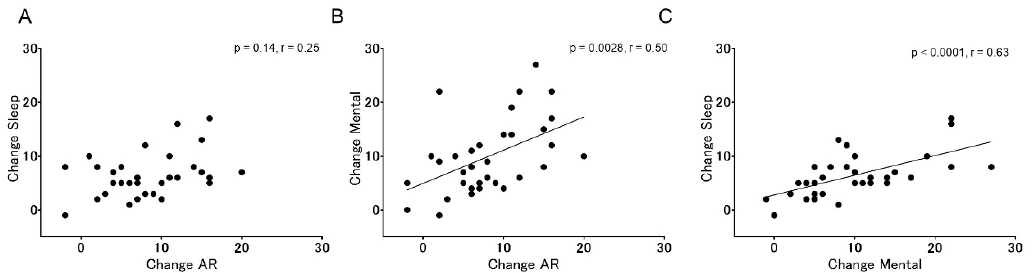
Figure 3. Correlations between changes in AR scores and those in sleep scores ( A ), between changes in AR scores and those in mental scores ( B ), and between changes in sleep scores and those in mental scores ( C ). A significant correlation was identified between AR and mental scores ( p = 0.0028, r = 0.50) or between sleep and mental scores ( p < 0.0001, r = 0.63) with Spearman rank correlation.